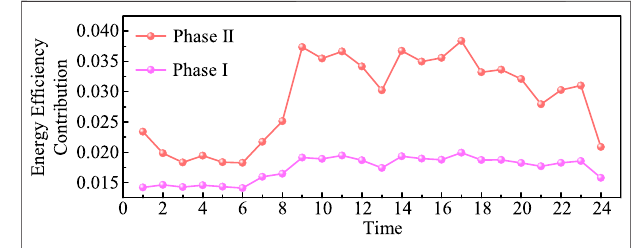
FIGURE 8 | The comparison of the cooling subsystem.